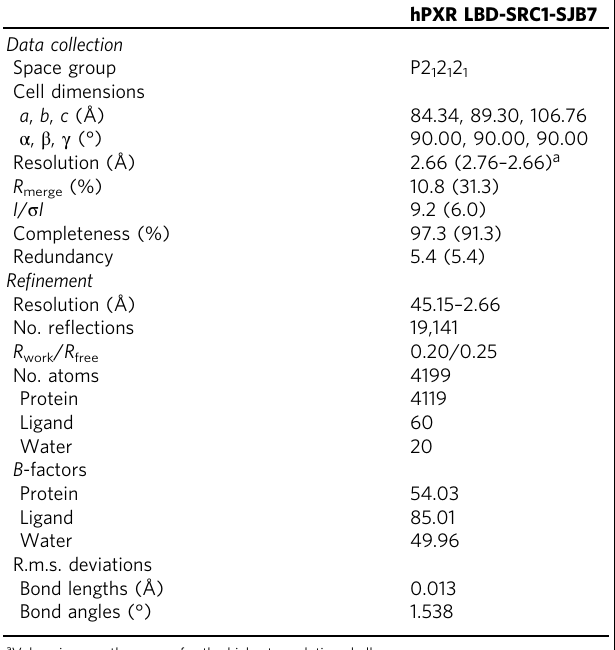
atoms. The hPXR LBD adopts an active conformation with the AF-2 helix (helix 12) positioned to favor co-activator binding, in which the SRC-1 peptide is seen packed against the AF-2 groove of each LBD.